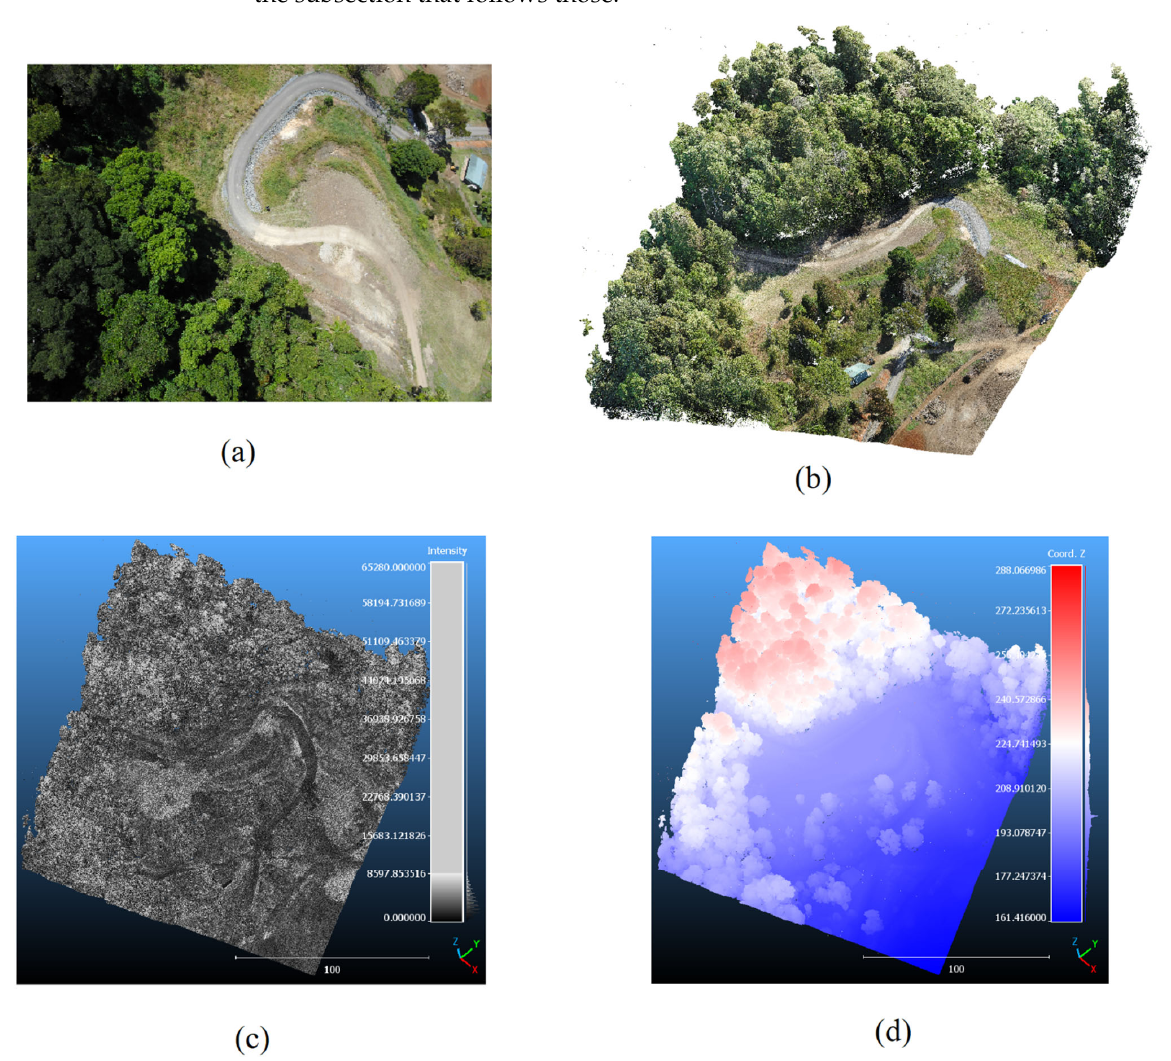
Figure 1. ( a ) Aerial image of scanned scene; ( b – d ) 3D LiDAR point cloud visualization ( b ) using RGB colors; ( c ) using laser intensity values; ( d ) using Z coordinate values.